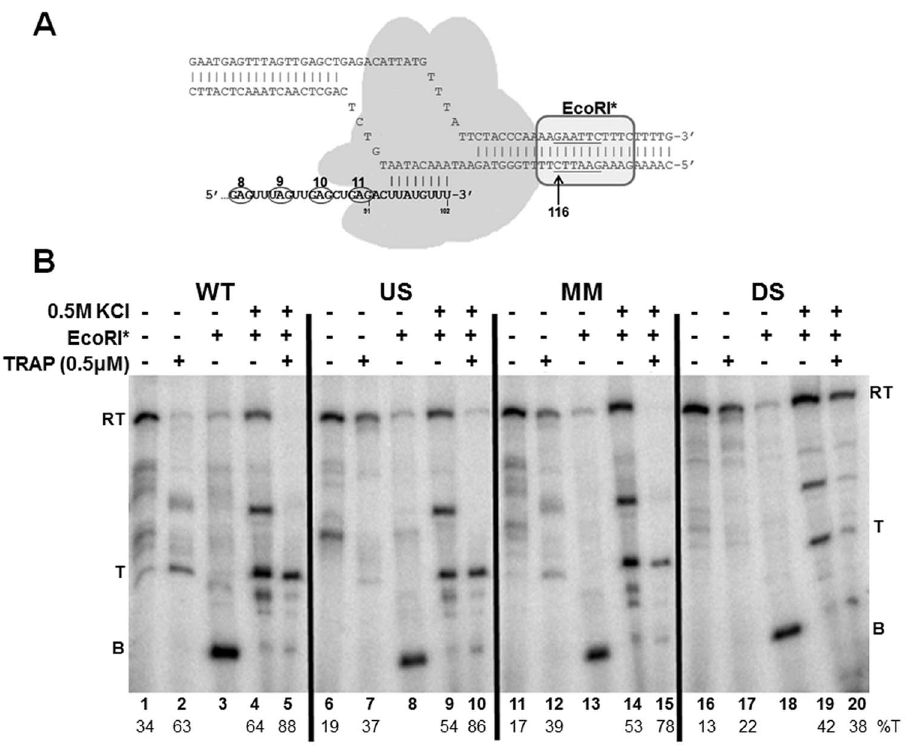
Figure 7. Blocking transcription elongation with EcoRI* to provide time for TRAP binding. (A) Diagram of EcoRI* blocking the transcription elongation complex. Cleavage defective E111Q EcoRI (EcoRI*) binds to its recognition site on the DNA template and blocks elongation of RNAP approximately 12–13 bp upstream of the first G of the GAATTC recognition site. EcoRI* is shown as an oval shape bound to its recognition site starting at + 116 in the trp leader region. RNAP is shown as a shaded grey shape. The nascent RNA is shown in bold with the 3 9 -most 8 residues paired with the template DNA. The last 4 (G/U)AG repeats of the TRAP binding site are circled. (B) Gel electrophoresis using a 6% polyacrylamide-8M urea gel analysis of block-and-release assay for the wild type (WT), U-stretch Disruption (US), C125G mismatch stem (MM), and disrupted stem (DS) attenuator templates. EcoRI* was allowed to bind to the DNA template prior to initiating transcription, TRAP was added, and transcription was then allowed to proceed until the TECs were blocked by EcoRI*. EcoRI* was then dissociated from the DNA by addition of 0.5 M KCl, allowing transcription to resume. The location of transcripts from blocked TECs (B), terminated at the attenuator (T), and read through (RT) transcripts are indicated on both sides of the gel. The percentage of transcription termination is displayed below the lane numbers (%T).